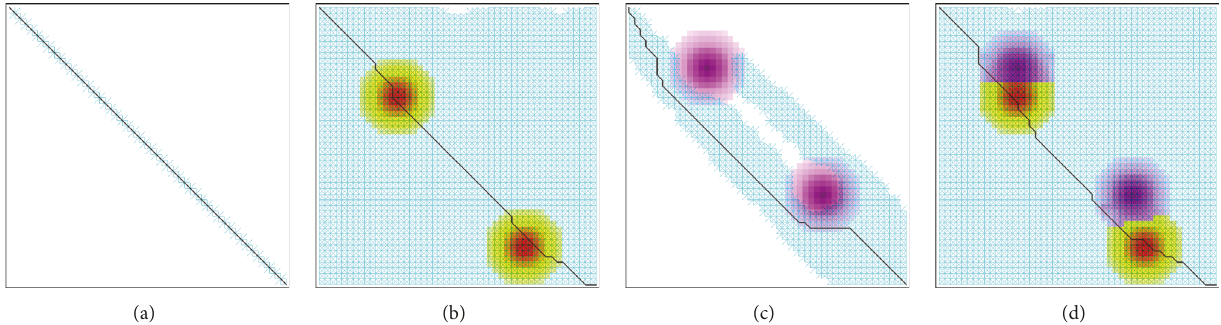
Figure 8: Finding a path (in black) from the top-left node to the bottom-right node of a 50 × 50 grid using the constraint-aware navigation A ∗ algorithm (A ∗ CAN): (a) without attractors and repulsors, the search space only covers neutral nodes (in cyan) along or close to the path (in black); (b) with 2 attractors, the search space almost covers the entire map, including neutral nodes (in cyan) and attractor nodes (in red-to-yellow blended with cyan); (c) with 2 repulsors, the search space covers neutral nodes (in cyan) found on the way to the goal node, and part of the repulsor nodes (those in purple blue as a result of blending light dark-to-light lilac with cyan); (d) with 2 attractors and 2 repulsors, the search space covers the entire map, including neutral nodes (in cyan), attractor nodes (in red-to-yellow blended with cyan), and repulsor nodes (in purple blue as a result of blending light dark-to-light lilac with cyan). Nodes in cyan or blended with cyan represent visited nodes, that is, nodes in the open and closed